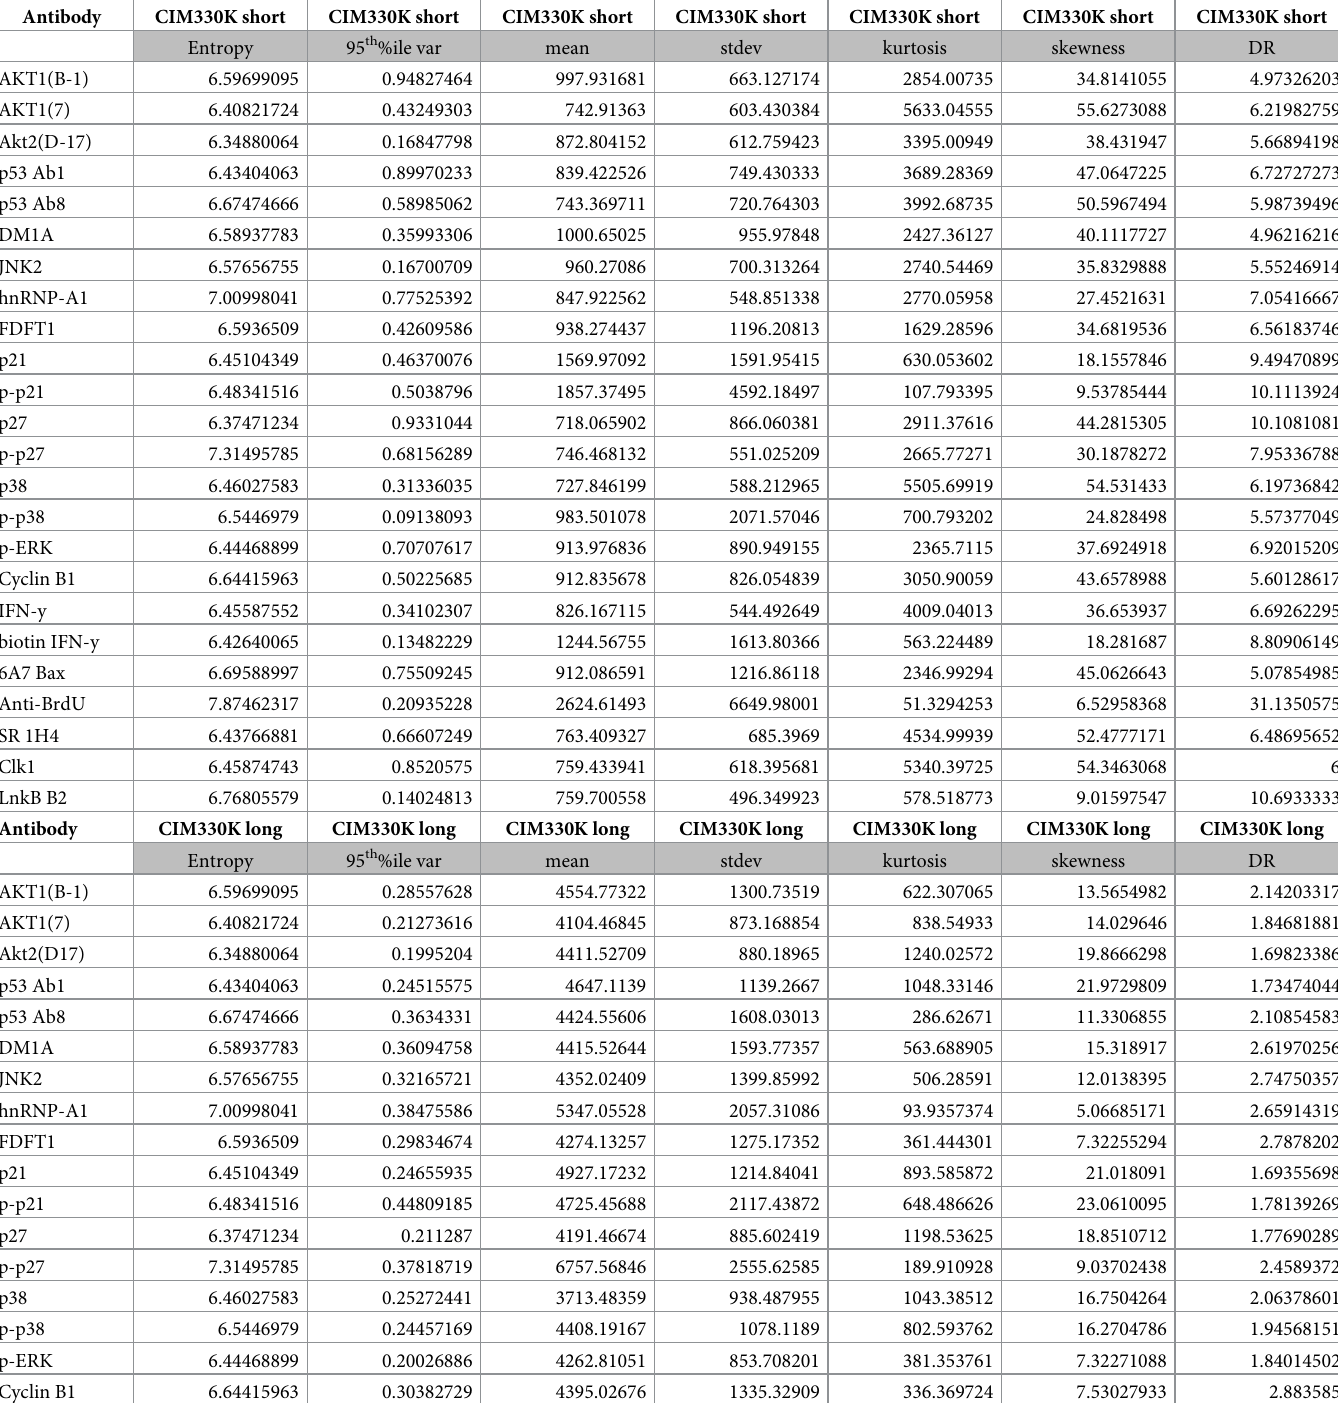
Table 4. List of selected characteristics of the data distributions from each of the peptide array formats. The table below lists seven different numerical descriptors of the full dataset from each peptide microarray library (330K short peptide, 330K long peptide, 125K short peptide, 124K short peptide), and for each antibody. In order, the descriptors are: Shannon’s Entropy [17], 95 th percentile coefficient of variance (calculated from the standard deviation / mean of the 95 th upper percentile of all observed fluorescence intensities for each antibody per peptide library), the mean of all intensities, the stdev of all intensities, the measured kurtosis of all raw intensities, the skew- ness of the raw intensity data distribution, and the dynamic range of the raw